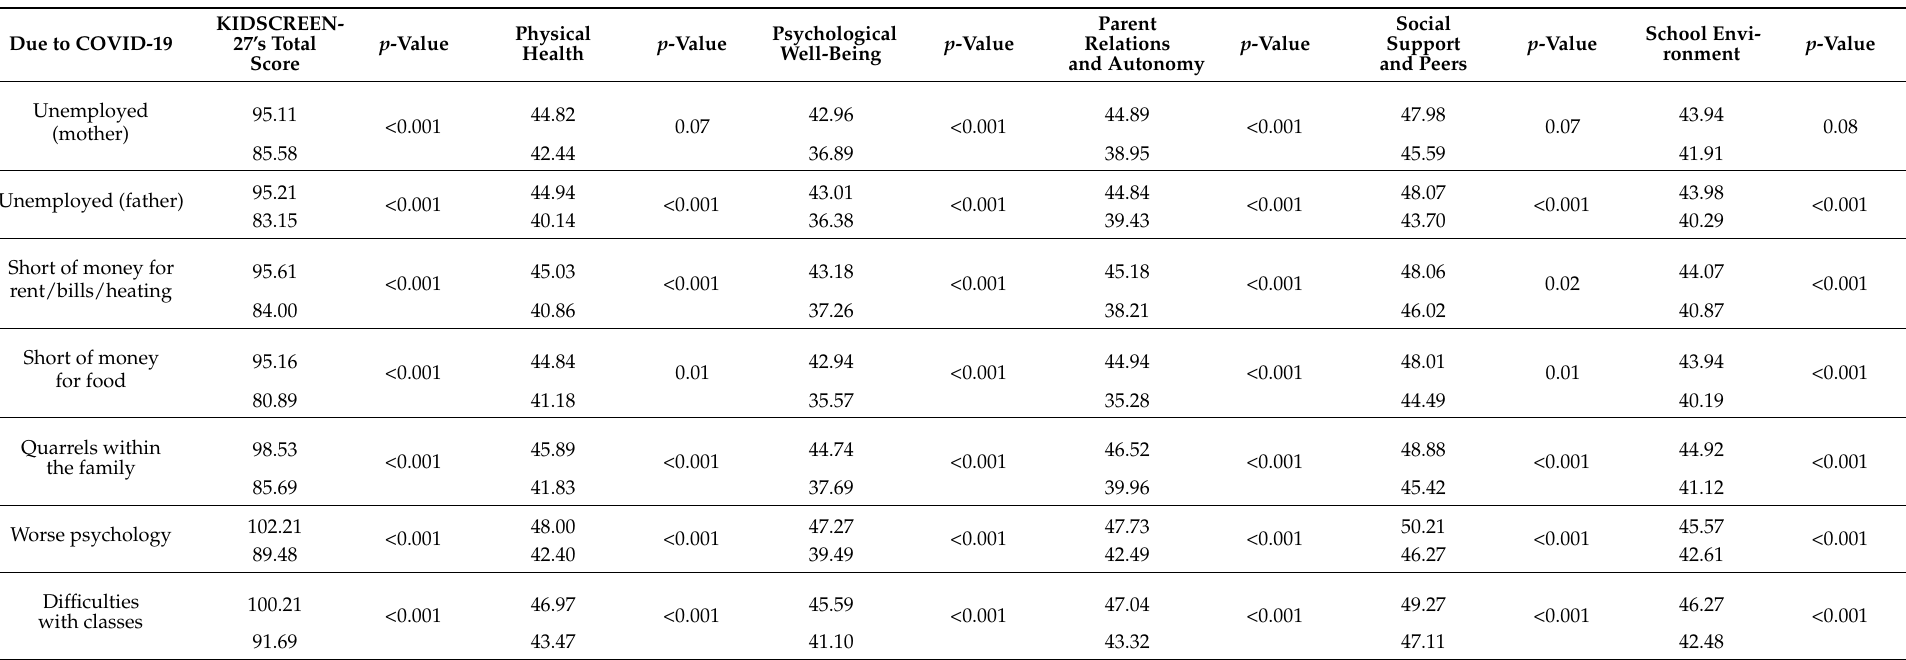
Table 3. KIDSCREEN-27’s total score and the five dimensions with respect to several variables related to the